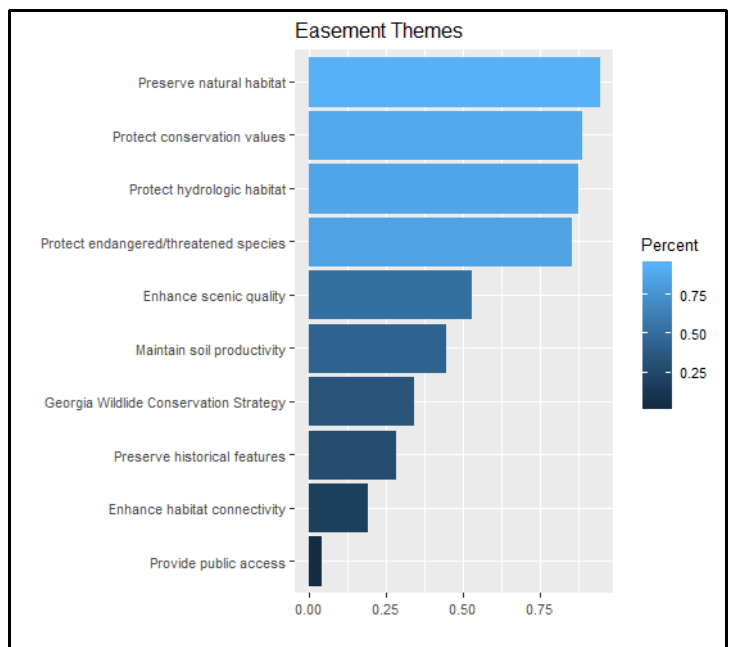
Figure 2. Listing of easement themes by their prevalence based on a total number of 86 WFCES in Georgia.